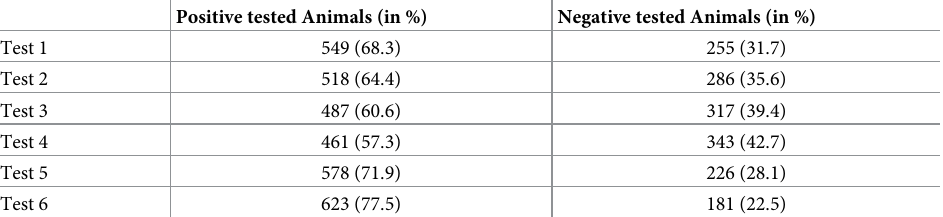
Fig 1. Step-by-step procedure for determining the starting values when taking various information sources into account. https://doi.org/10.1371/journal.pone.0262944.g001 4. Define starting value datasets: All available information on the test accuracies, the depen- dencies and the prevalence are combined. Every possible combination forms a starting value set. The exact number of the resulting sets depends on the amount of prior Table 1. Observed frequencies of the two results for all six tests used in the latent class analysis of the complete dataset (percentage rounded to one